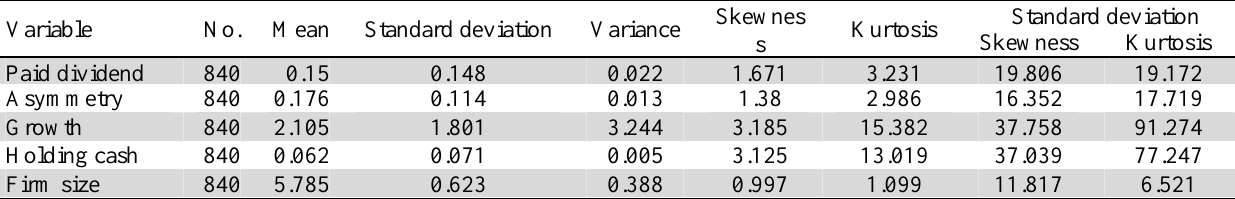
The summary of basic statistics